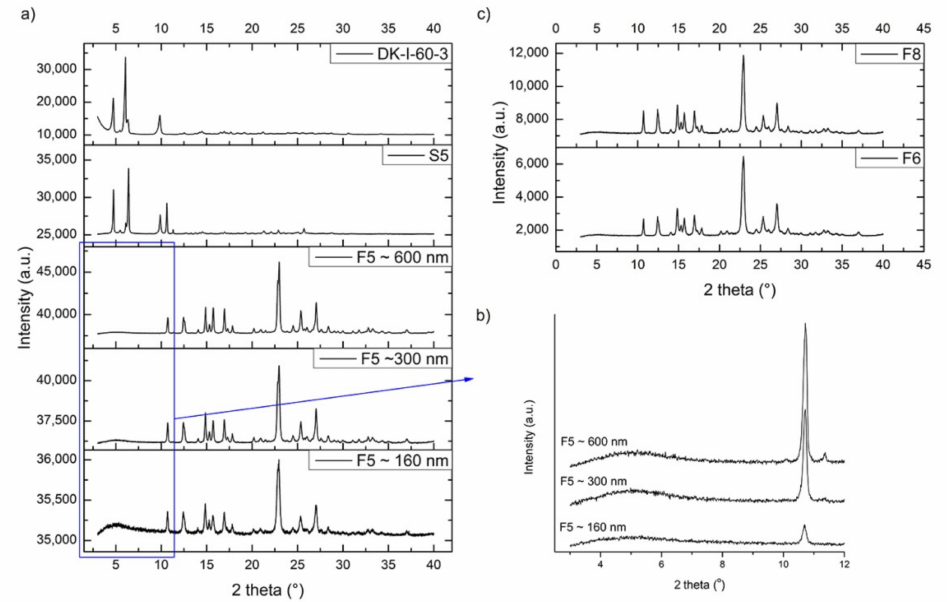
Figure 5. ( a ) XRPD patterns of unprocessed DK-I-60-3, suspension S5 and nanocrystal dispersion F5 with different particle size; ( b ) diffractograms of nanocrystal dispersion F5 with different particle 3–12 ◦ 2 theta; ( c ) XRPD patterns of nanocrystal dispersions F6 and